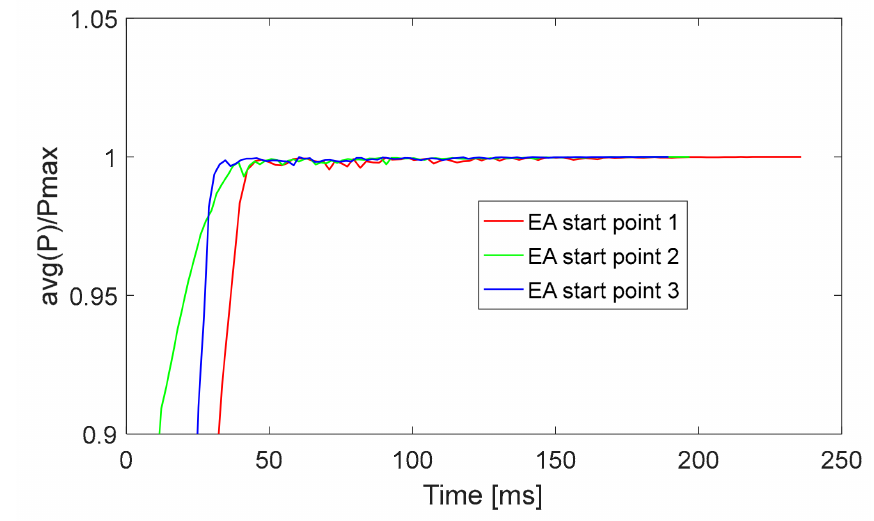
Figure 6. Average fitness into population progress